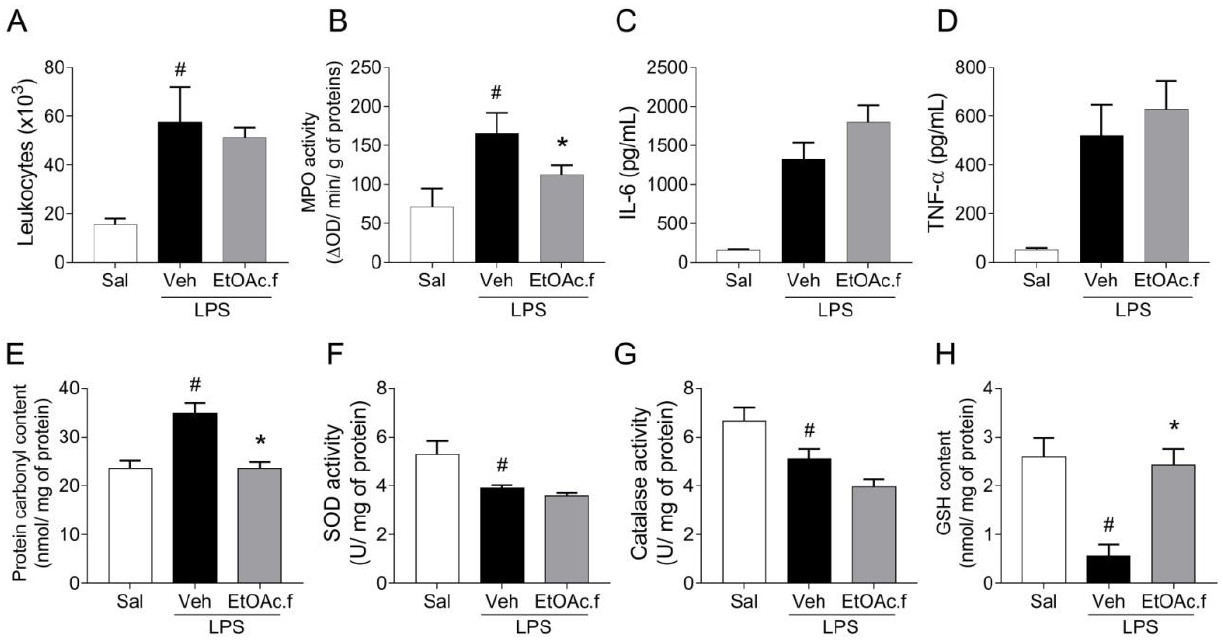
Figure 4. EtOAc.f presents anti-inflammatory and antioxidant activities in LPS-induced acute lung injury. Mice were pretreated with EtOAc.f (30 µg/mL, via oral) 24 h and 1 h before intranasal LPS (10 µg/40 µL) challenge and then, at 24 h after LPS administration, inflammatory ( A – D ) and oxidative ( E – H ) markers were assessed. ( A ) The total number of leukocytes present in BALF. ( B ) MPO activity evaluated in lung tissue. ( C ) Levels of IL-6 and ( D ) TNF- α determined in BALF through ELISA assay. ( E ) Protein carbonyl, ( F ) superoxide dismutase, and ( G ) catalase activity. ( H ) glutathione content was assayed in lung tissue homogenates. Data represent mean ± S.E.M. of one representative experiment ( n = 5 mice/group). # and * indicate a statistically significant difference comparing to saline (Sal) group or vehicle (Veh) group, respectively; p <